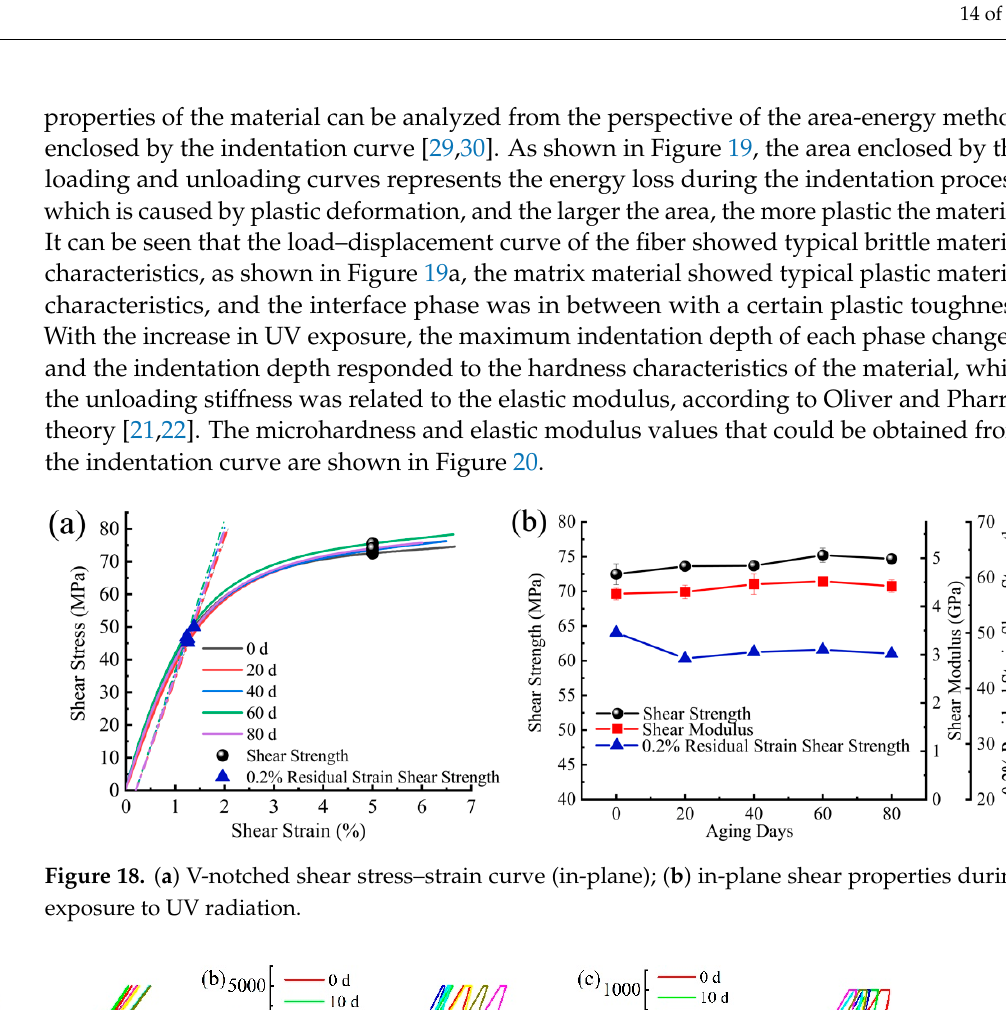
Figure 17. ( a ) Interlaminar stress–displacement curve; ( b ) interlaminar shear strength versus UV aging time curve.